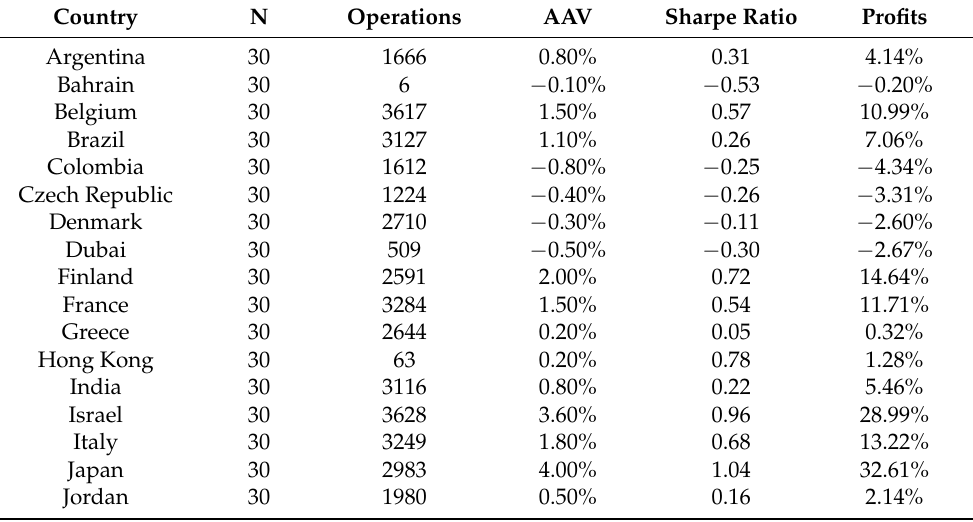
Table A2. Results obtained for the period 2000–2007 (30 Pairs), where N is the number of pairs; AAV Average annualized return; and Profit is the profitability for the full period with transaction